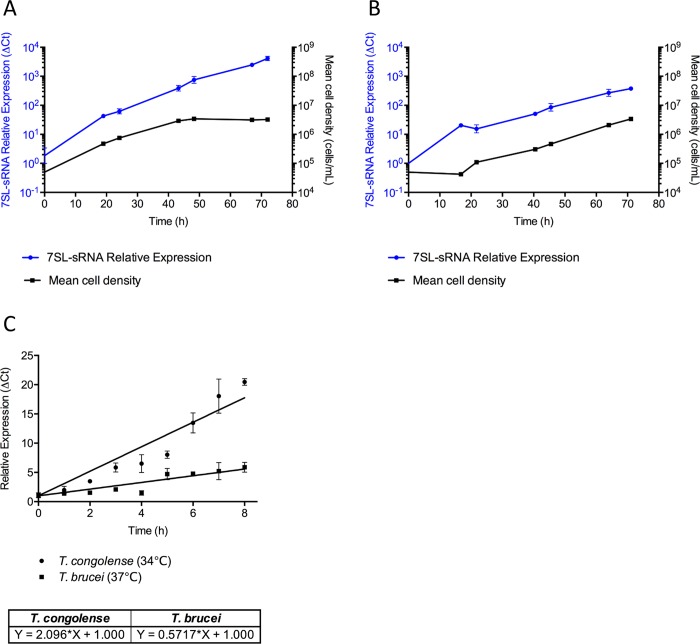
7SL-sRNA abundance is correlated to cell density in cultured trypanosome supernatants.Cell density of in vitro cultures of T. brucei (A) and T. congolense (B) was monitored over time and supernatant samples were simultaneously isolated for 7SL-sRNA detection (n = 2 per time point). (C) Relative levels of the 7SL-sRNA, normalized to the 0 hour time-point control, were observed to increase as cell density increased; statistical significance of correlation between cell density and relative Ct value was calculated by Spearman Rank correlation and Pearson’s product moment correlation.